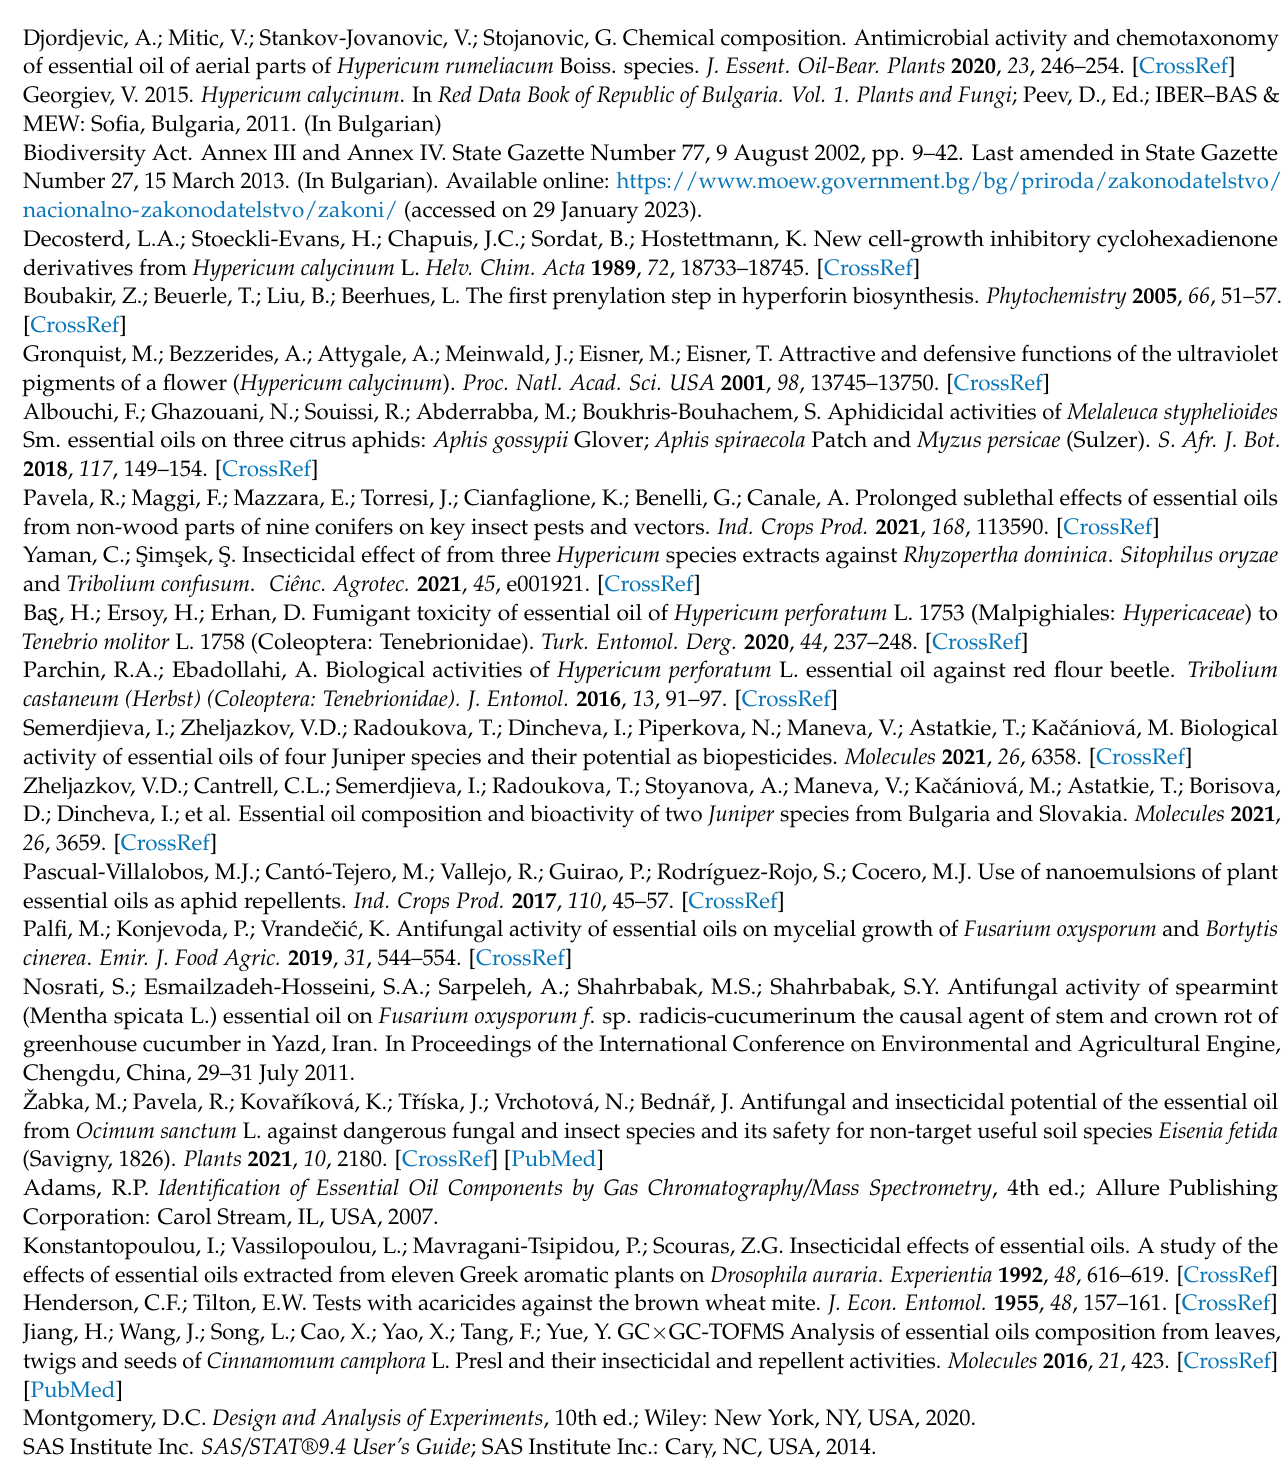
Table 5. The insecticidal effect of commercial EOs of H. perforatum from Bulgaria (Com, Bul) on two aphids (Rhopalosiphum padi and Sitobion avenae) (mean ± SD). After 24 h in % ± EO Concentrations (%)